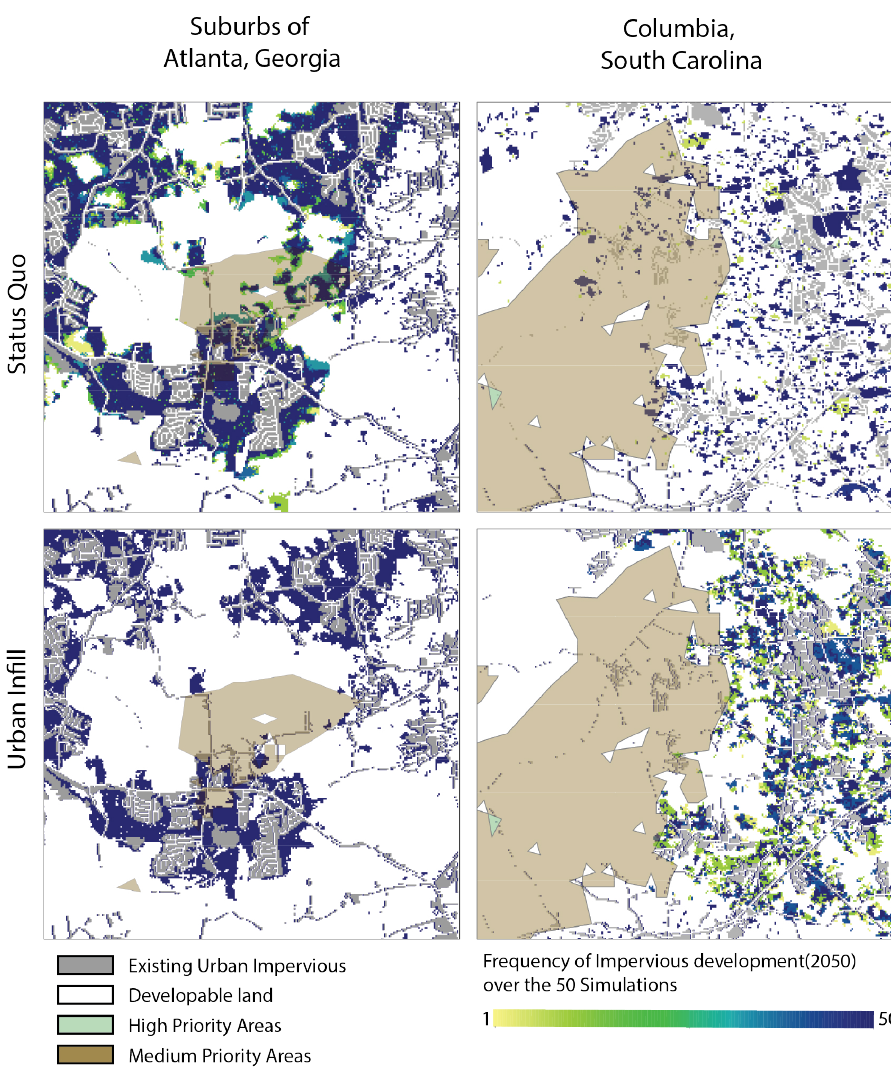
Figure 5. Percent losses (pattern and frequency) of status quo and infill urban development encroaching on ecological priority areas (Olliff et al.,